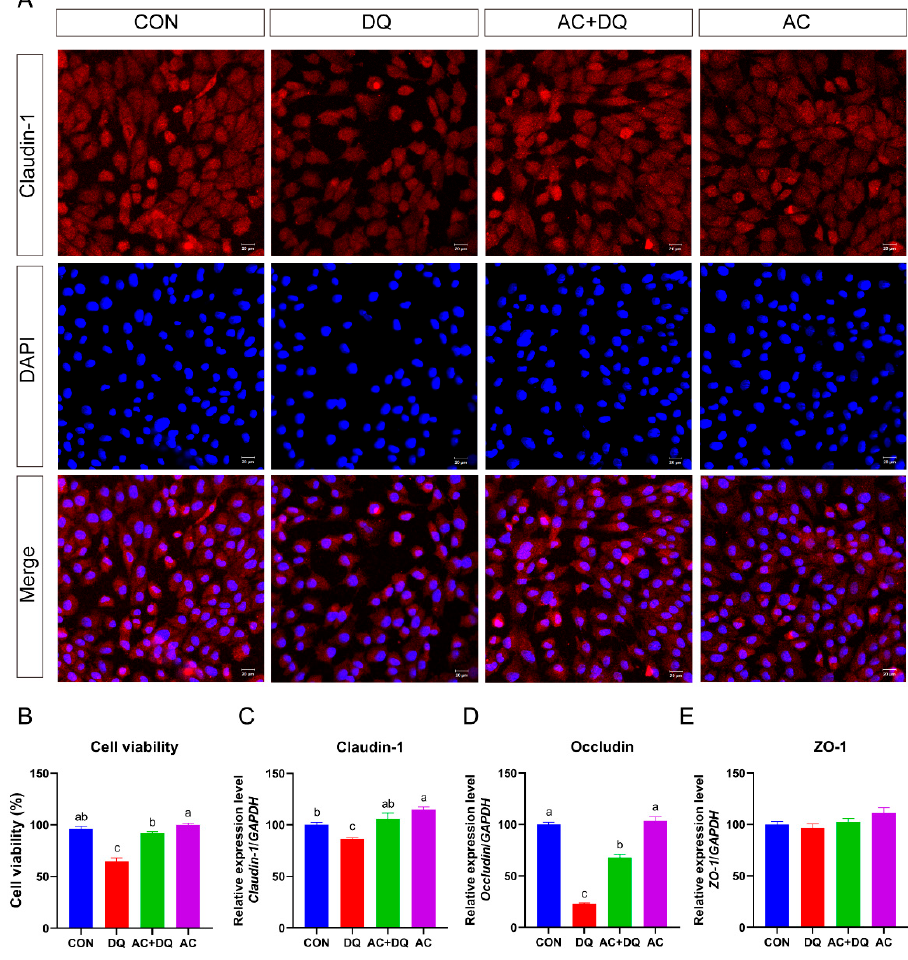
Figure 3. Effects of acidifiers on the expressions of tight-junction-related genes in diquat-challenged IPEC-J2 cells. ( A ) Localization of the tight-junction protein claudin-1 by immunofluorescence staining. IPEC-J2 cells were plated in 12-well plates at a density of 1 × 10 5 cells per well and pretreated by 0.005% acidifiers for 4 h, and the cells were then challenged by diquat (1150 μ M) for 6 h. Immunofluorescence staining of IPEC-J2 cells with claudin-1 (red) and DAPI (blue). Magnification 20×, and scale bars representing 20 μ m. ( B ) Assays of cell viability. ( C ) The mRNA expression level of claudin-1 ( CLDN1 ). ( D ) The mRNA expression level of occludin ( OCLN ). ( E ) The mRNA expression level of ZO-1. CON, cells without being treated; DQ, cells were only treated by 1150 μ M of diquat for 6 h; AC + DQ , cells were pretreated by 0.005% acidifier for 4 h and were then treated by 1150 μ M of diquat for 6 h. AC, cells were only treated by 1150 μ M of acidifier for 6 h. All values were represented as means ± SEM ( n = 6). Different superscript letters denote a statistically significant difference between groups ( p < 0.05), while same letters denote no significant difference.